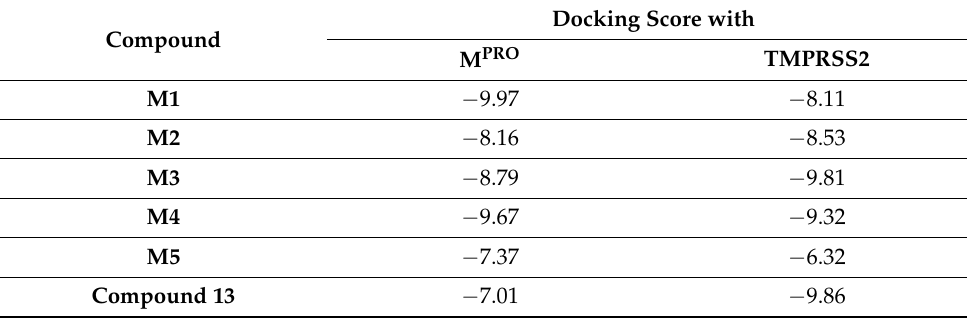
Figure 2. Chemical structures of the shortlisted compounds M1–5 and Compound 13 with potential inhibitory activity to SARS-CoV-2. Table 1. Docking score of shortlisted compounds against M pro and TMPRSS2.